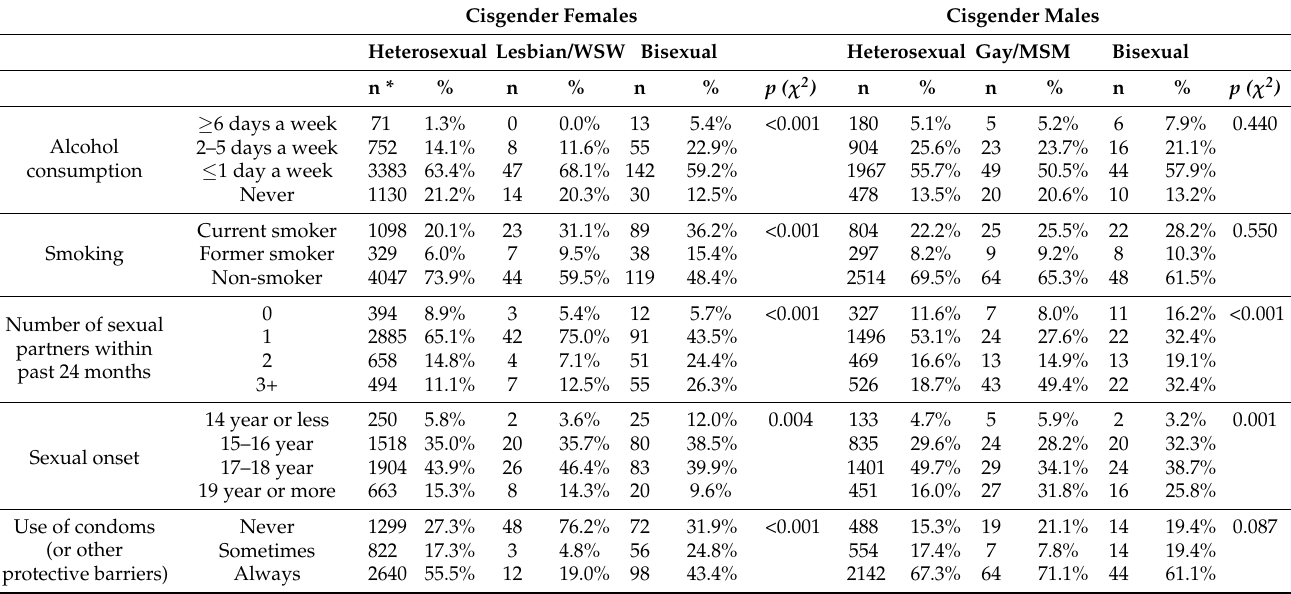
Table 2. Prevalence of risk behaviours in the study